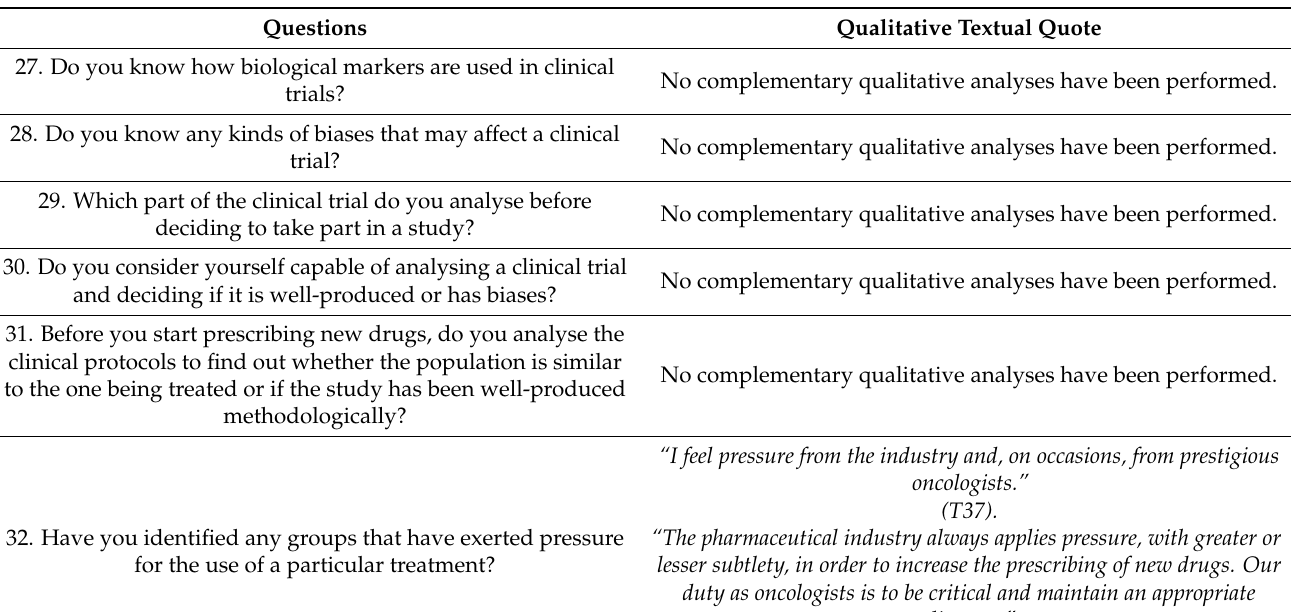
Table 4. Qualitative analysis of knowledge of clinical trials. Galicia,